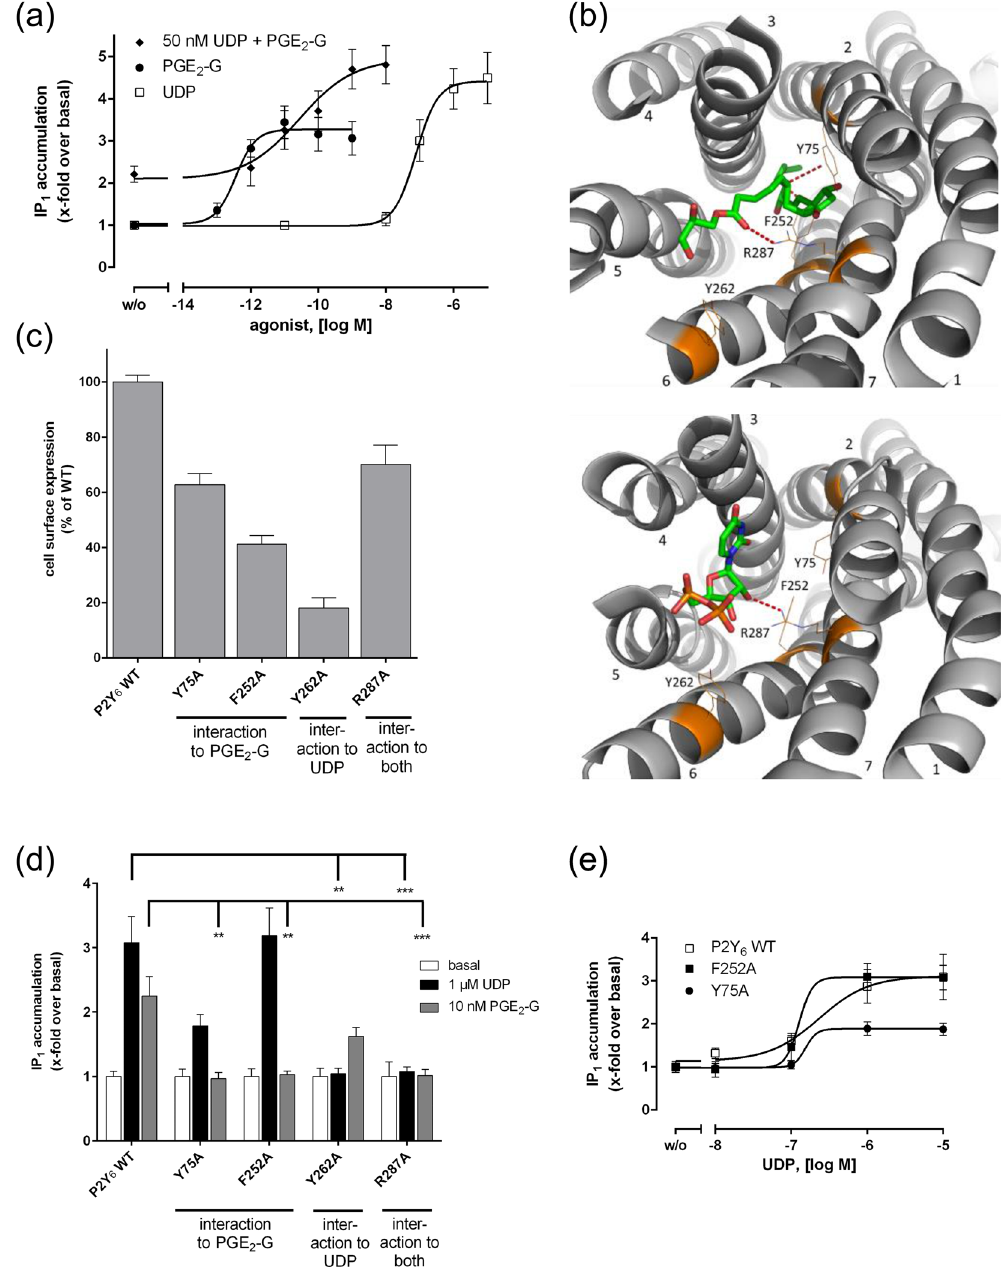
Figure 6. UDP and PGE2-G have overlapping agonist binding sites. ( a ) Concentration-response curves of UDP and PGE 2 -G alone and of PGE 2 -G + 50 nM UDP on HEK293 cells transfected with P2RY6 were determined in IP 1 accumulation assays ( see Methods ). EC 50 values for UDP and PGE 2 -G were 18.9 ± 2.3 nM and 0.3 ± 0.1 pM, respectively. ( b ) Extracellular view of the top scoring pose of PGE 2 -G (green) docked in the comparative model of the P2Y 6 receptor (gray) (top) and top scoring pose of UDP (green) (bottom). Side chains of residues Y75, F252, Y262, and R287 are indicated as orange lines. Interactions captured in the majority of the top scoring poses are indicated as dashed red lines. Helices are numbered from N- to C-terminal. ( c ) Cell surface expression of mutant P2Y 6 receptors was determined as described. Optical density (OD) is given as percentage of P2Y 6 WT minus OD of mock-transfected cells. Data are given as means ± SEM of three independent experiments performed in triplicate. ( d ) and ( e ) HEK293 cells were transfected with wildtype and mutant P2RY6 and IP 1 accumulation assays were performed as described. ( d ) Indicated concentrations of UDP and PGE 2 -G were tested on mutant P2Y 6 receptors. ( e ) Indicated concentrations of UDP revealed EC 50 values of 15.4 ± 0.9 nM and 12.7 ± 2.1 nM for Y75A and F252A, respectively. All data are means ± SEM of three independent experiments, each performed in triplicate. * p < 0.05, ** p < 0.01, *** p < 0.001 (paired Student’s t